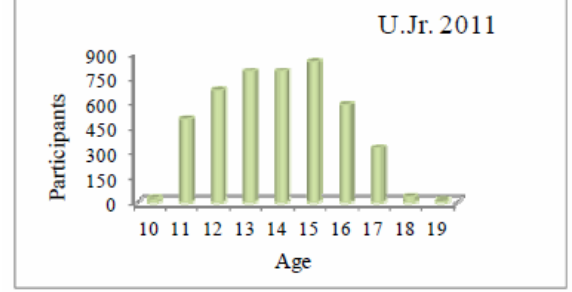
Figure 2. Age distribution in the 2011 edition [5]